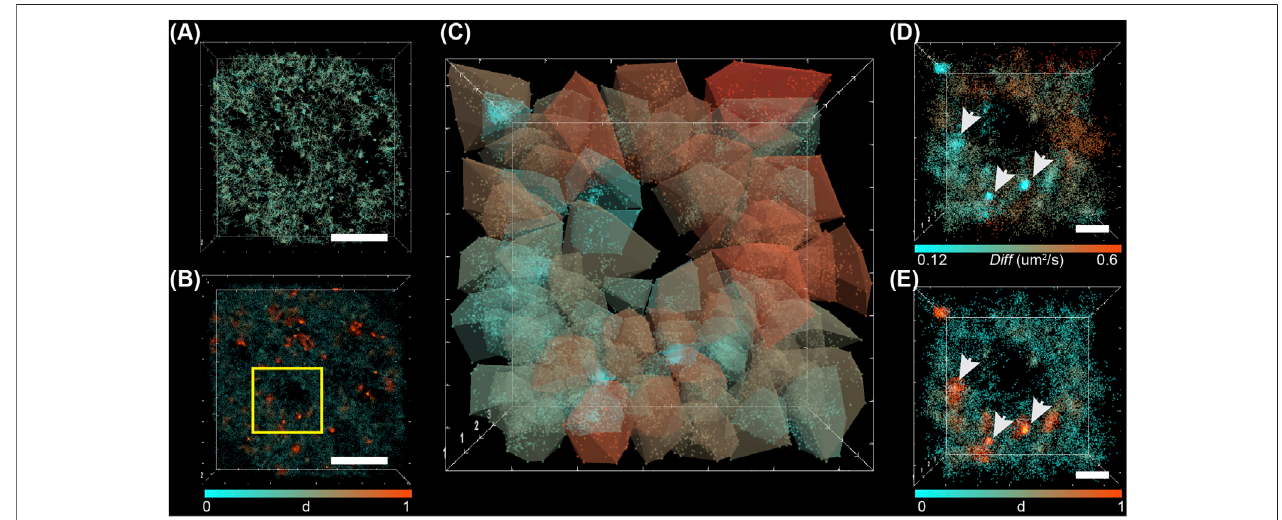
FIGURE 6 | Pipeline for calculating 3D diffusion map of point cloud dynamic data. (A) Reconstructed 3D trajectories of beads injected in the nucleus. (B) A slice in the reconstructed volume shows a point cloud color-coded by the local density ( d ). A very heterogeneous density is observed pointing towards different chromatin compaction. (C) 3D diffusion map generated over a small nucleus area represented by the blue square in (B) . The different areas are presented by surfaces with controllable transparency andcolor-codedbydiffusion( Diff ). (D) Toeasily visualizethediffusionlandscapepoint cloudsarecoloredbythediffusioncoef fi cient.The arrows point toward examples of low diffusivity area where particles are assumed to be trapped. This hypothesis is supported by the corresponding high local density estimation as presented by (E) . Scale bar: 5 microns in (A) and (B) , 1 micron in (D)